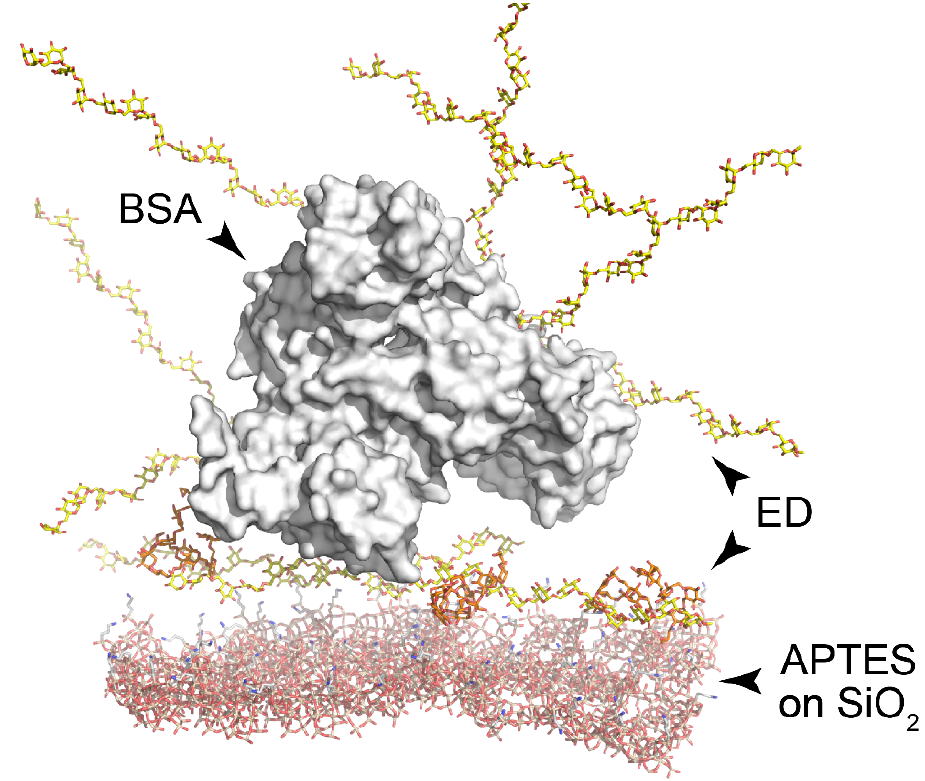
Figure 3. Visualization of macromolecular complexes at the PC surface. Silanized surface of silica (bottom, red); ED layer (yellow); BSA molecule (white surface). Amino groups are colored in blue.